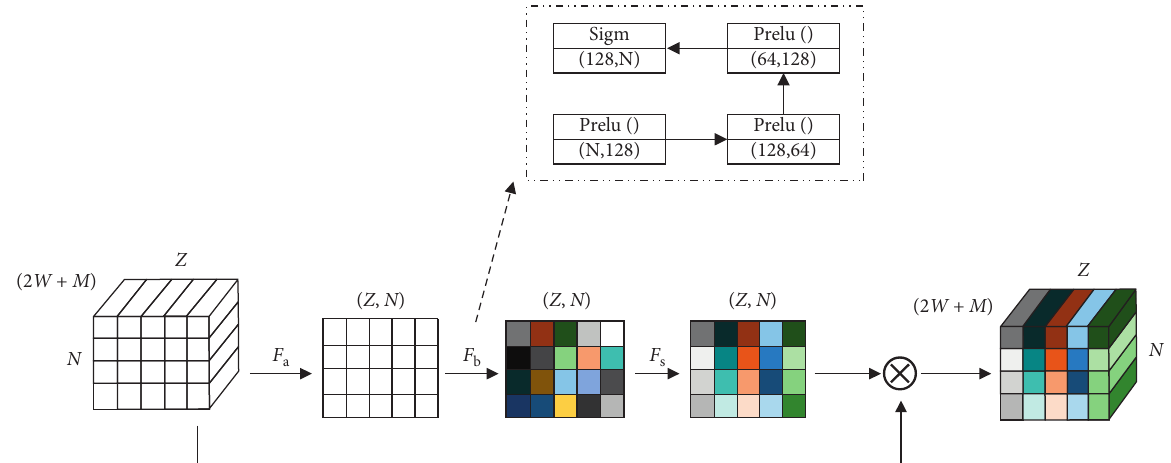
Figure 2: The module of the frame-level interchannel attention mechanism: different colors represent different weight values, and multiply the weight values with the original